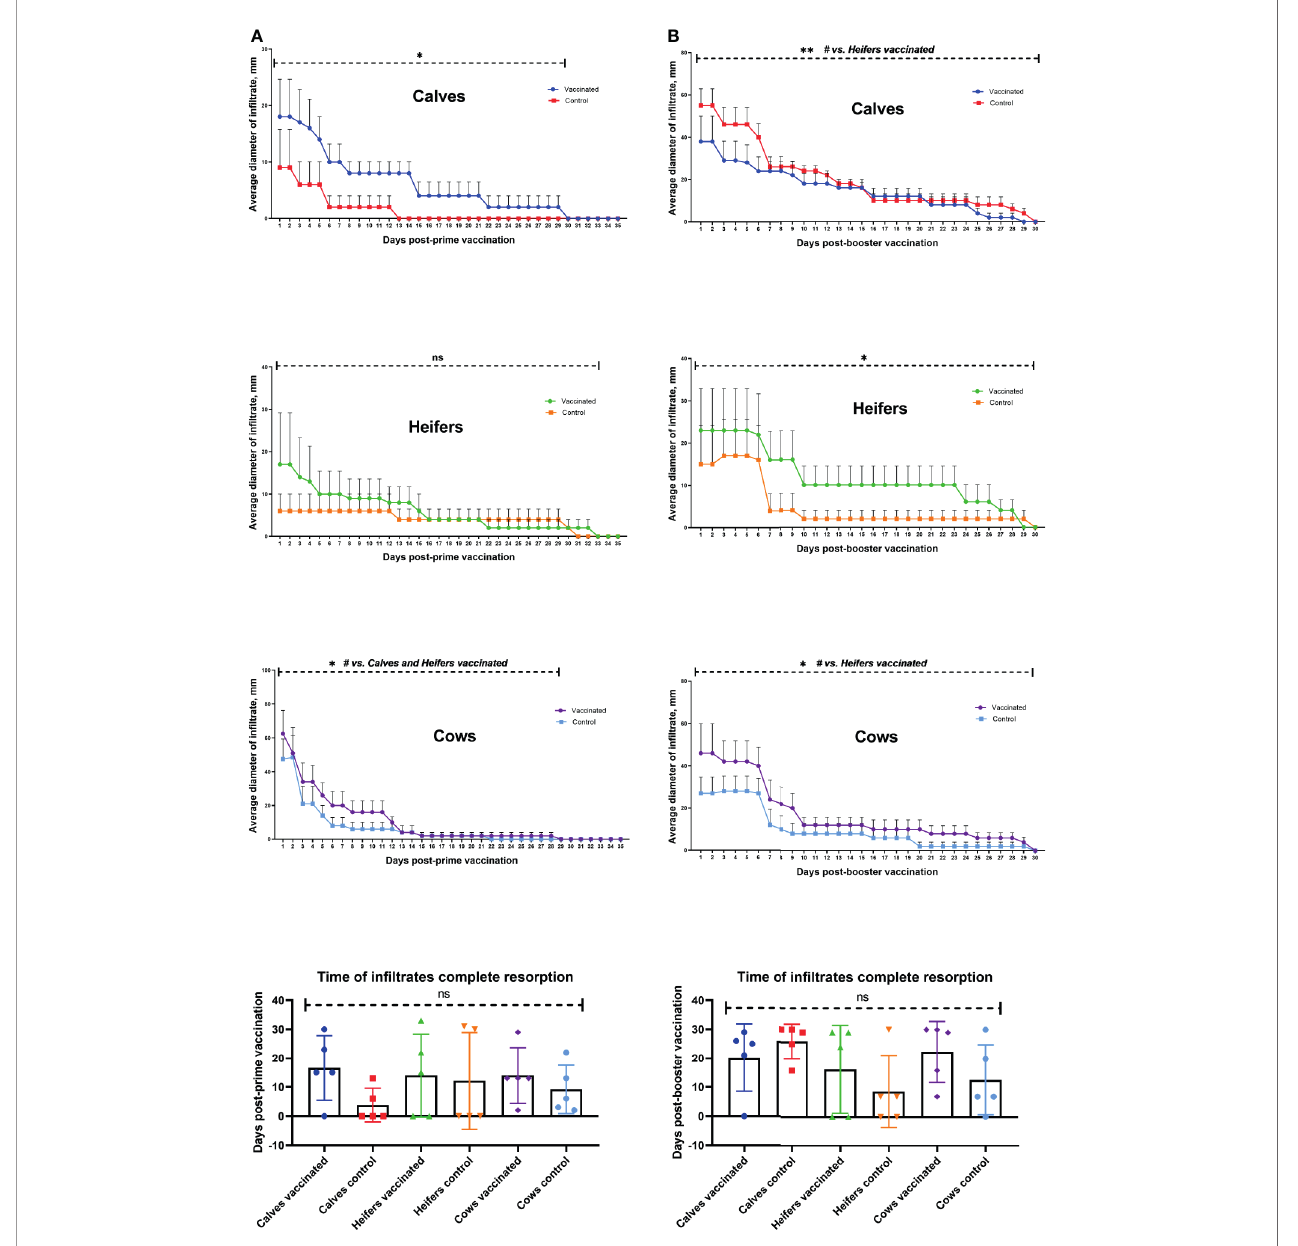
FIGURE 3 | Dynamics of formation and resorption of in fi ltrates at the site of vaccination of different age groups of cattle within 35 days after prime (A) and 30 days after booster (B) . The calves, heifers, and adult cows in the vaccinated group were immunized twice via the subcutaneous route at an interval of 28 days with vaccines generated from the IVV subtypes H5N1 (prime vaccination) and H1N1 (booster vaccination). Animals in the control group were subcutaneously injected with 1.0 ml of 20% Montanide Gel01 adjuvant in PBS. Average in fi ltrate diameters were expressed in mm. The data was presented as means with standard errors (SEM). * P = 0.0025 − 0.0005 vs. appropriate control group; ** P = 0.0033 vs. Calves vaccinated; # P = 0.0025 − < 0.0001 ; ns — P = 0.25 − > 0. 9999. Statistical analysis was performed using two-way ANOVA followed by Tukey ’ s multiple comparisons test. P values < 0.05 were considered signi fi